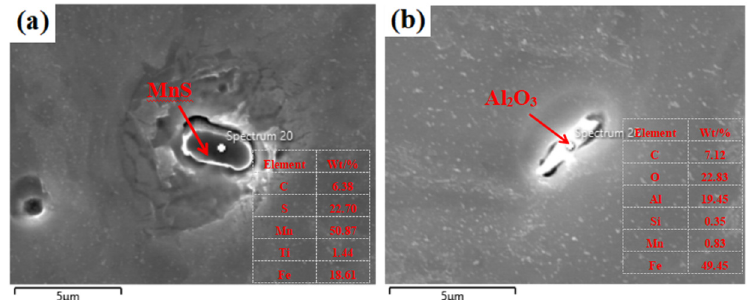
Figure 4. Morphology and compositions of inclusions in 1# as-cast tested steel. ( a ) Mns; ( b ) Al 2 O 3